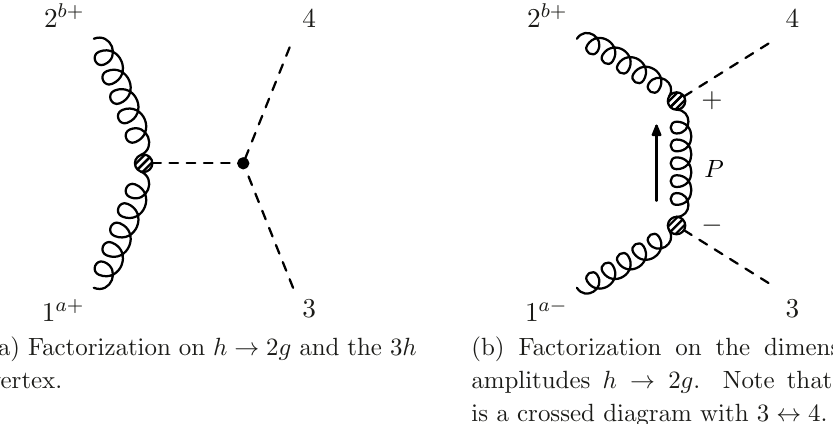
Figure 3. Possible factorizations of the 2 h